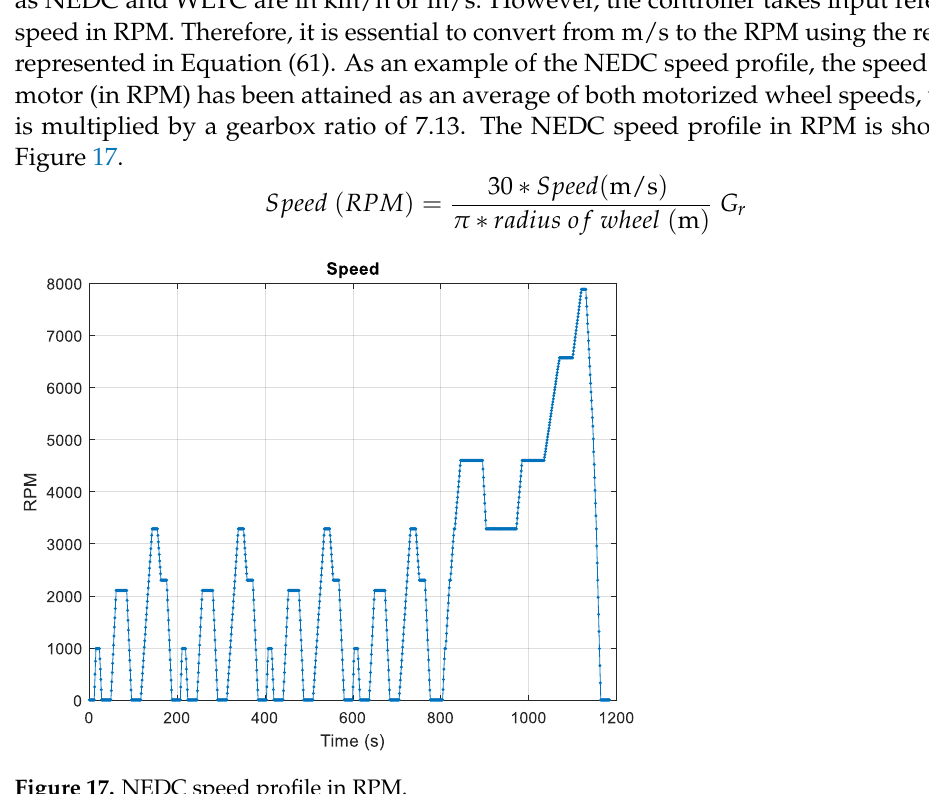
Figure 17. NEDC speed profile in RPM.